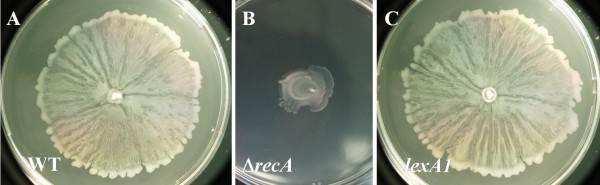
Swarming colonial patterns. Swarming colonial patterns developed on a semisolid "Difco" agar surface for 24 h at 37°C by (A) MG1655 wild-type, (B) MG1655Δ(srlR-recA)306::Tn10, and (C) MG1655 lexA1. Plates have a diameter of 9 cm.